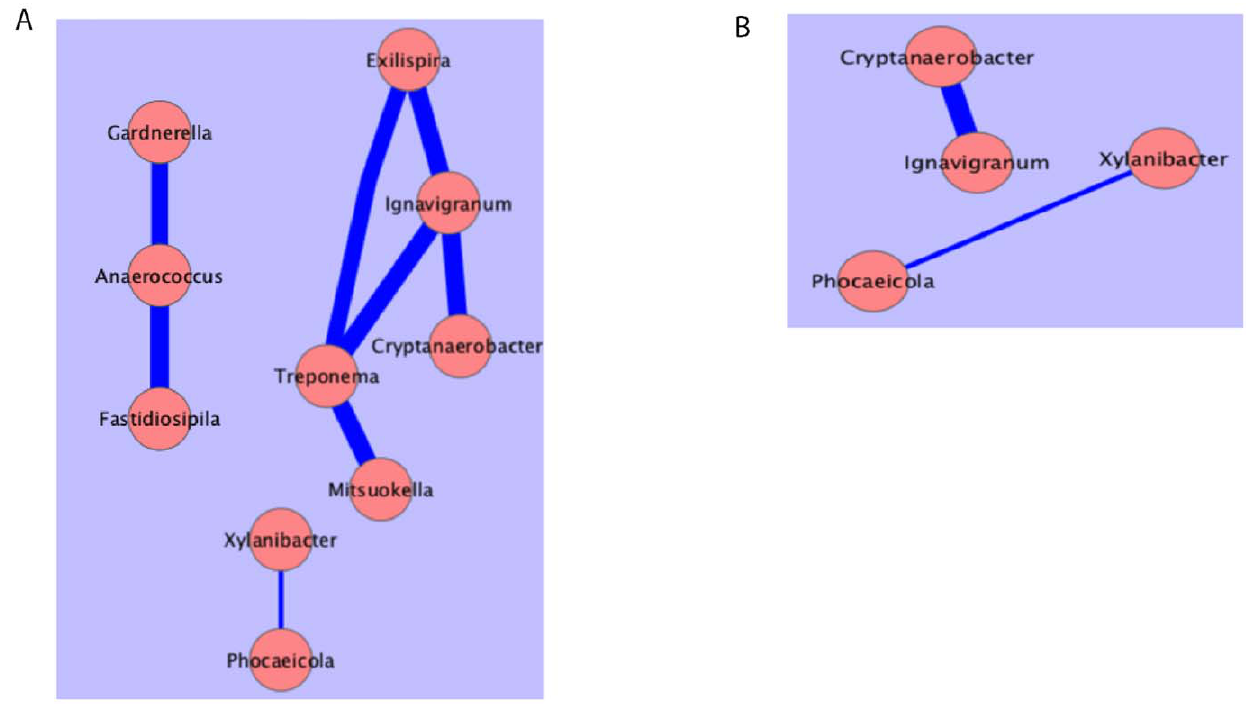
Figure 6. Network of statistical correlations between microbiota. A. Strong ( . 0.7) correlations between Microbiota at time point 1. B. Intersection of strong correlations that existed at both time 1 and time 2. Pink circles bacterial DNA levels. The blue lines indicate a positive correlation between the parameters in the circles and the width of the line is proportional to the strength of the correlation.